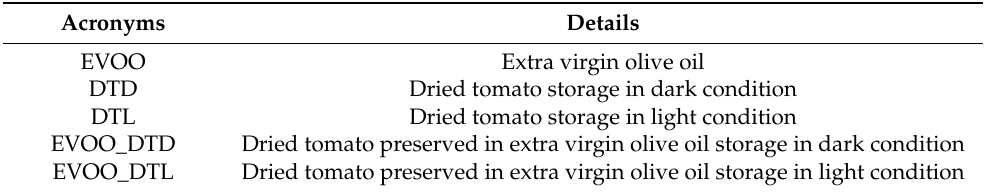
Table 1. Acronyms of analysed